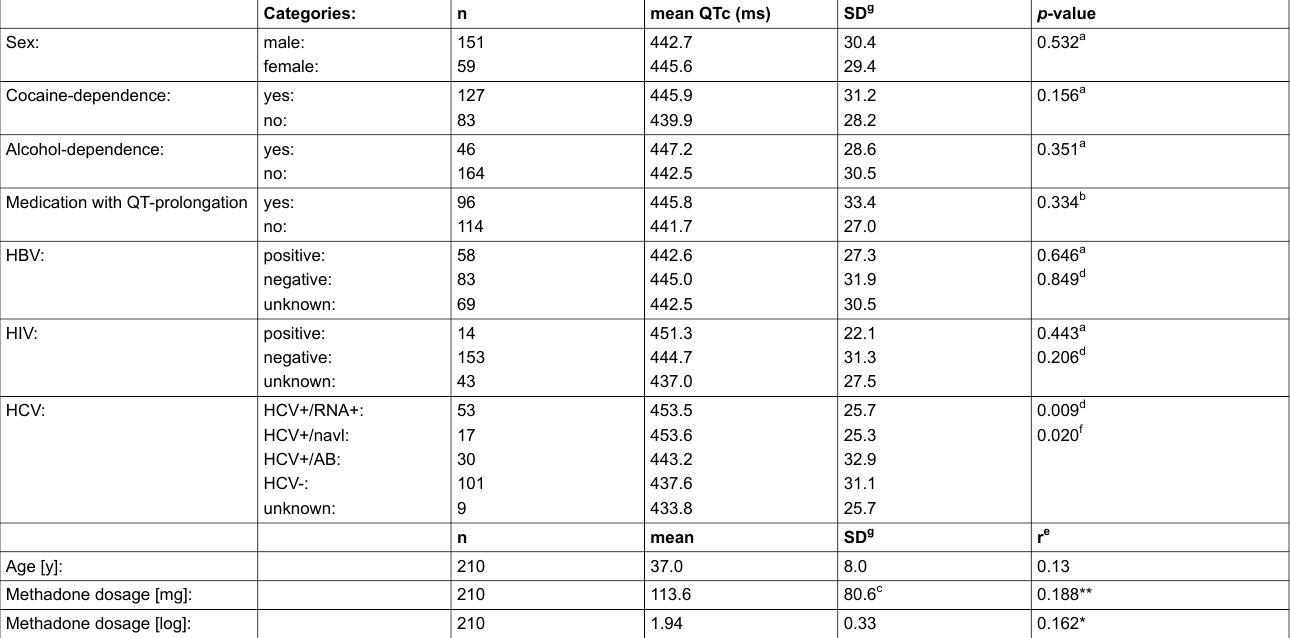
Table 1: Number of patients, means and standard deviations of QTc-time, and corresponding p -values of zero-order